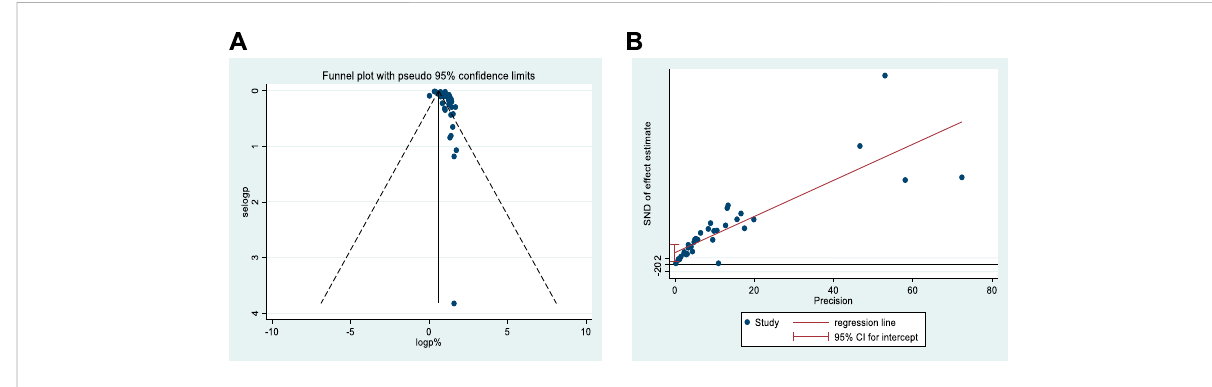
FIGURE 3 Probability of publication bias for included studies (A) funnel plot and (B) Egger ’ s publication bias plot.